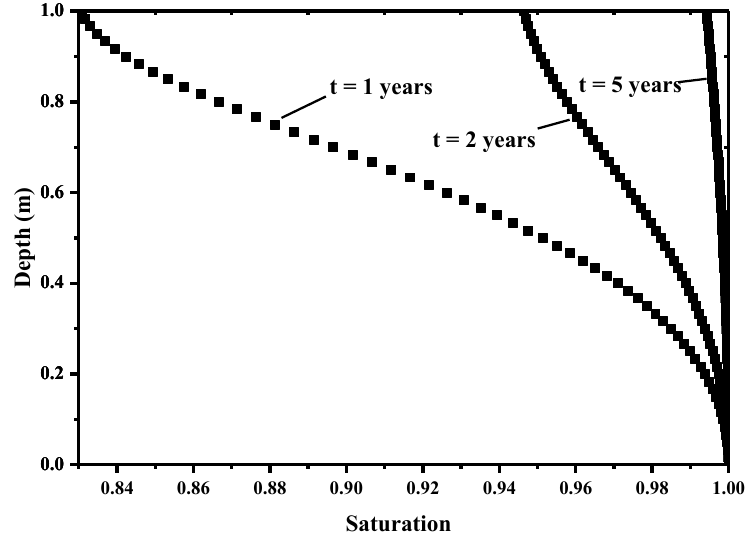
Figure 14. Saturation profile at different consolidation times.